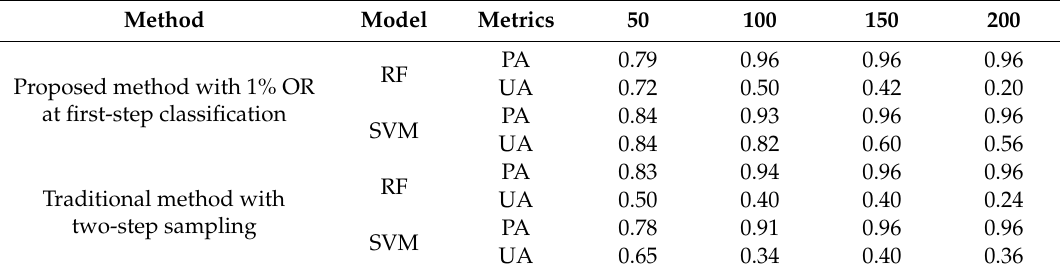
Table 6. Mean testing accuracy on classifying kudzu objects by four machine-learning models over 100 runs.